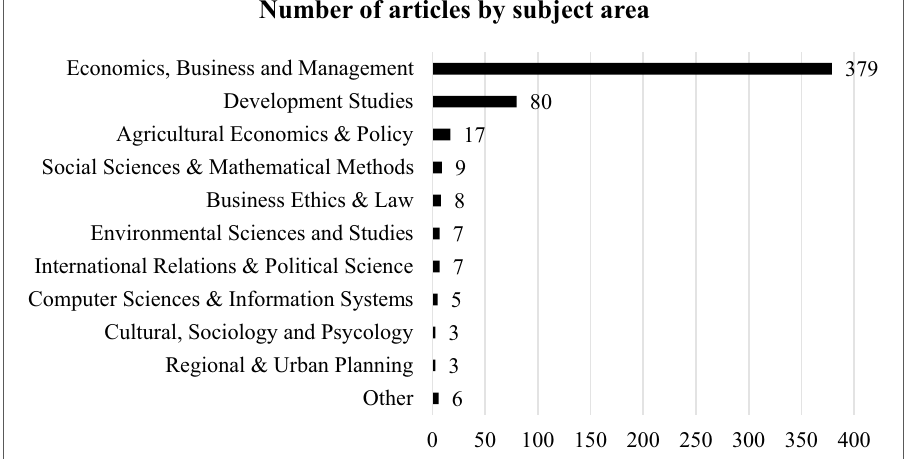
Fig. 3 Top 10 subject areas in microfinance (demand side) research in the 524 published articles, indexed to WoS between 1:2012 and 3:2021